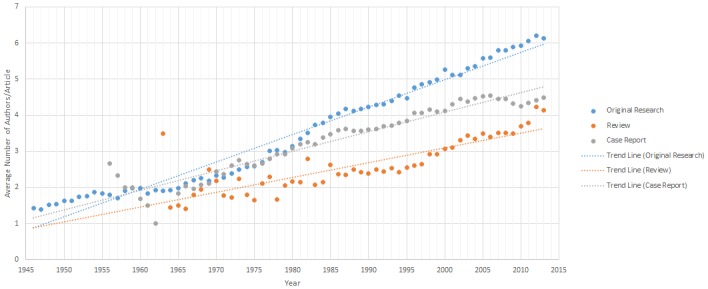
Mean Number of Authors/Article from 1946–2013 by Publication Type.This graph shows the mean number of authors/article for the three publication types analyzed: 1) Case Reports, 2) Reviews and 3) Original Research.